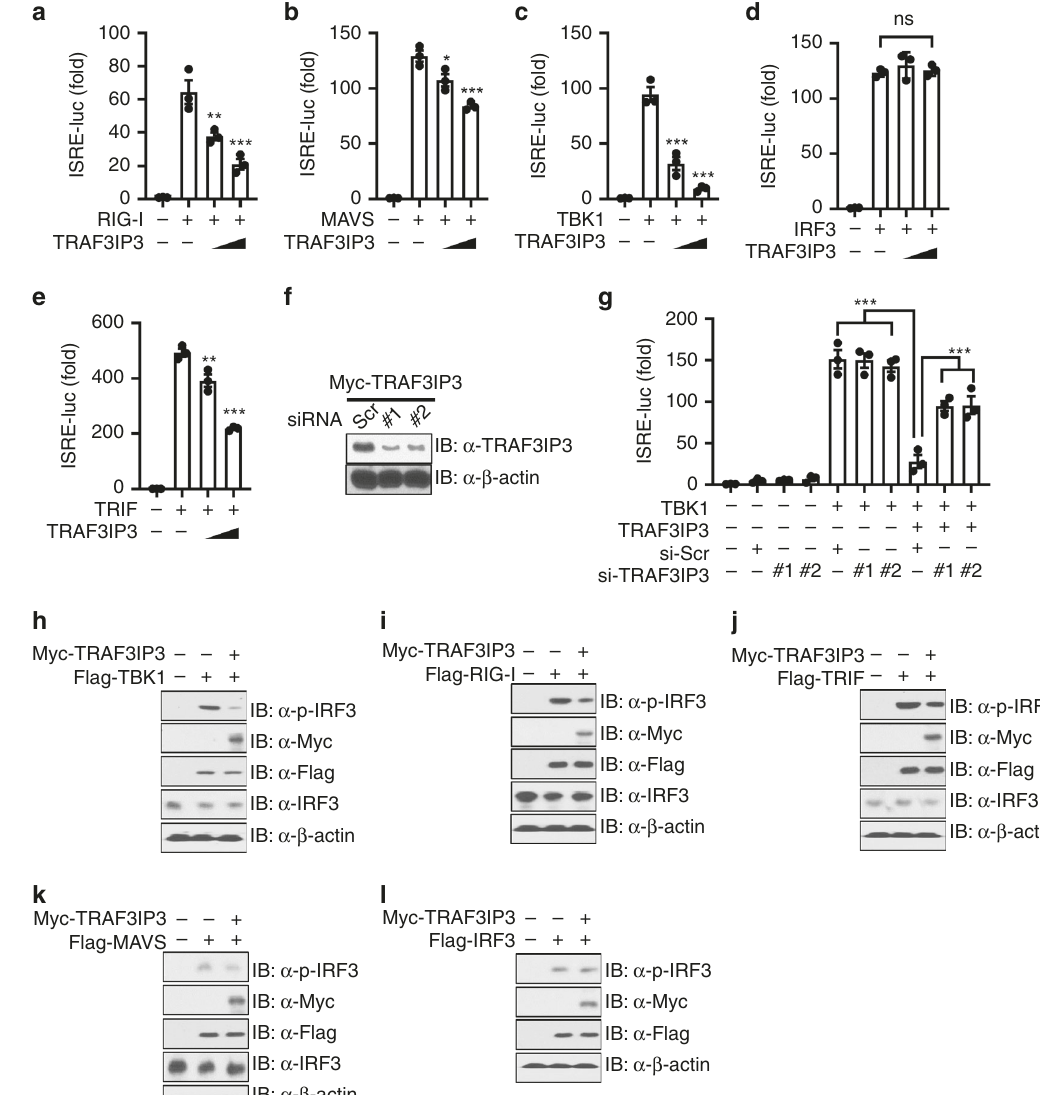
Fig. 4 TRAF3IP3 inhibits RIG-I-MAVS-TBK1 signaling. a – e Luciferase assay in HEK293T cells transfected with ISRE reporter, Flag-tagged indicated expression vectors, along with empty vector or increasing doses of Myc-TRAF3IP3 vector (wedge). Renilla luciferase was used as the internal control. f Immunoblotting of HEK293T cells transfected with Myc-TRAF3IP3 together with scramble and two TRAF3IP3 targeting siRNA. g Luciferase assay in HEK293T cells transfected with ISRE reporter, EV, HA-TBK1 or Myc-TRAF3IP3 vector, together with scramble or two TRAF3IP3 targeting siRNA. Renilla luciferase was used as the internal control. h – l Immunoblotting of HEK293T cells transfected with Myc-TRAF3IP3 and the indicated FLAG-tagged expression vectors. Data are presented as mean ± SEM and are one representative of three independent experiments. a – e , g , one-way ANOVA followed